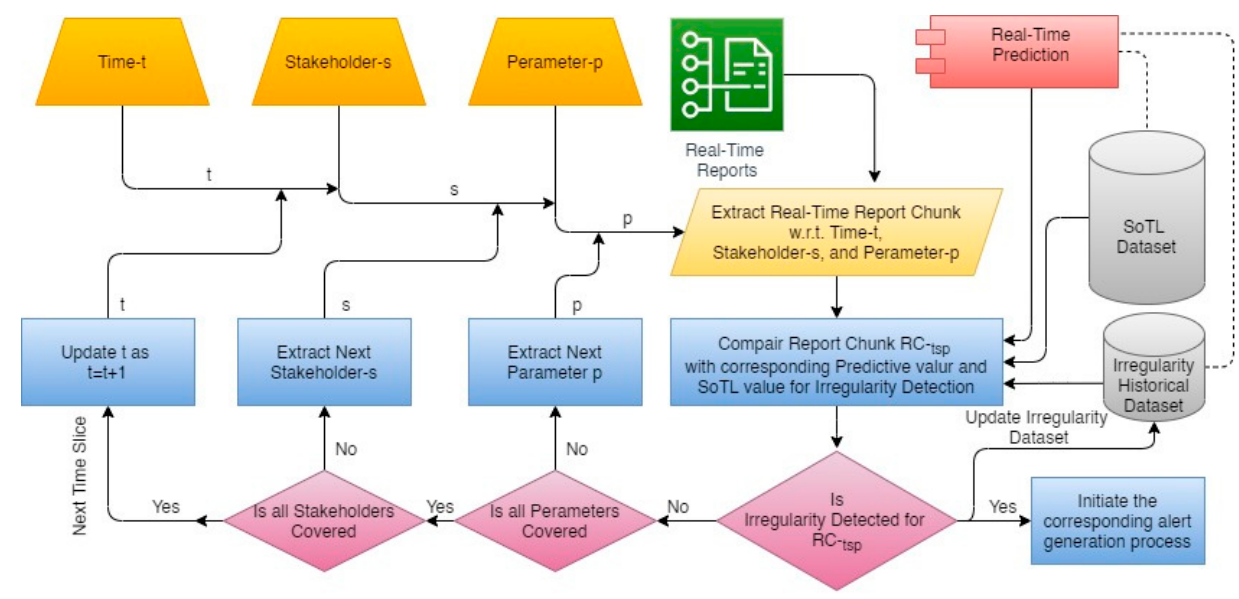
Figure 5. Real-time irregularity detection under Education 4.0.